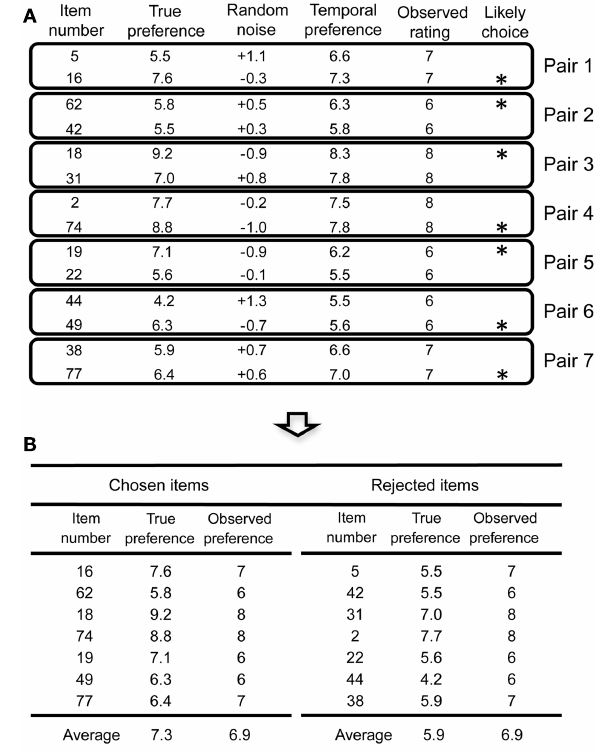
FIGUREA1 | (A) Table including information about true preference, random noise, temporal preference, and observed ratings. Items are paired on the basis of observed ratings, but true preference is sometimes substantially different between the two items in a pair. Items with the asterisk are more likely to be chosen (i.e., they have higher true preference than their counterparts). (B) We sorted the items based on the likely choice suggested in (A) . Although the observed preference is equivalent, the chosen items have higher true preference than the rejected